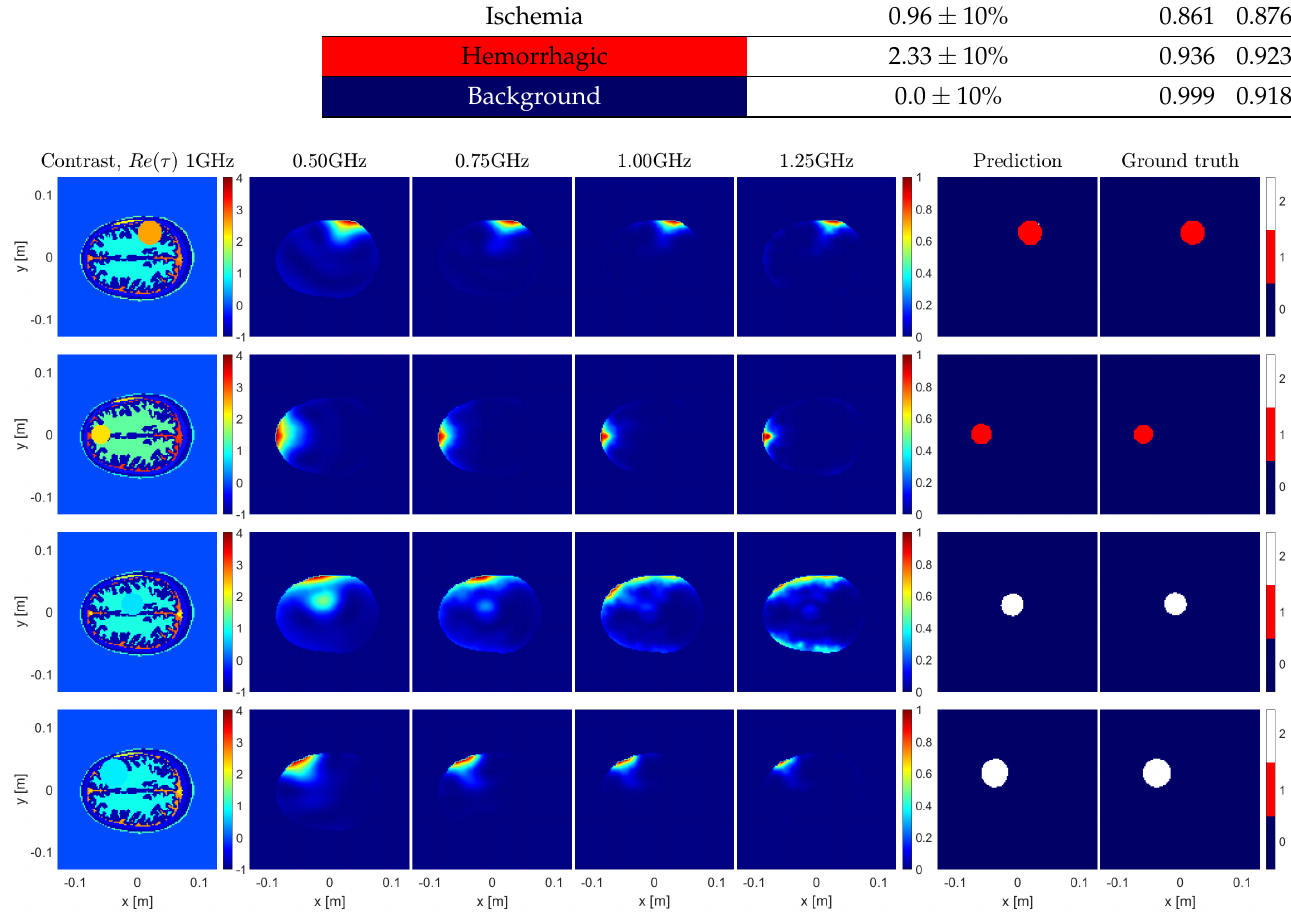
Figure 5. Sample results for the brain imaging example. The first column depicts the contrast of the imaged samples. The following 4 columns represent the OSM indicators at 0.5, 0.75, 1.00, and 1.25 GHz. The 6th and 7th columns show the predictions made by the U − Net and their corresponding ground truths,